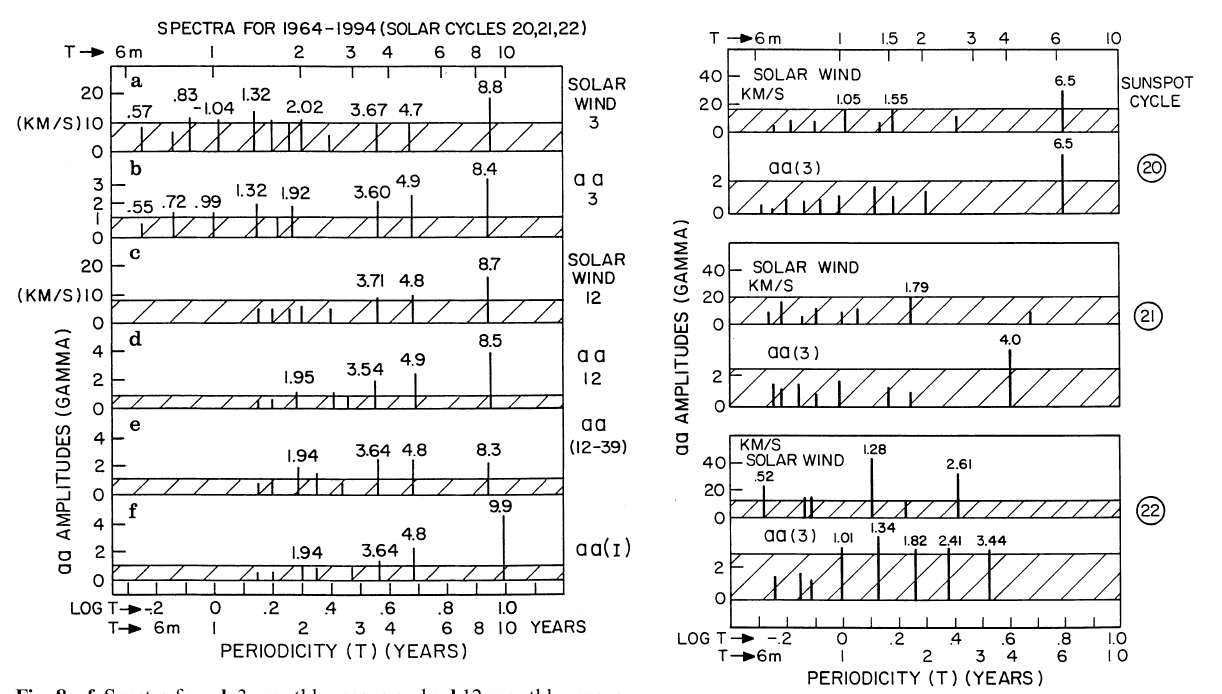
Fig. 9. Spectra for 3-monthly means of solar wind and aa indices for cycles 20, 21,